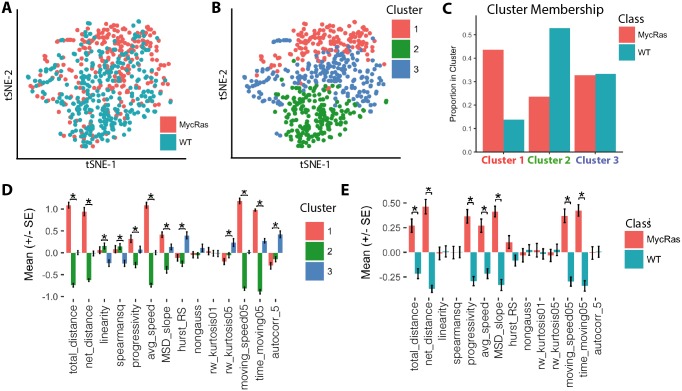
Wild-type and Myc/Ras transformed MEFs show differential occupancy within a shared motility state-space.(A) t-SNE visualization of wild-type (blue) and Myc/Ras transformed (red) MEFs in motility space (perplexity = 50). (B) Hierarchical clusters visualized with t-SNE (MANOVA, p < 0.001; Silhouette Si = 0.21). (C) Proportion of wild-type vs. transformed cells occupying each cluster. (D) Comparison of a subset of normalized feature values between clusters (*: Holm-Bonferroni corrected p < 0.01 by ANOVA) and (E) wild-type and transformed MEFs (*: Holm-Bonferroni corrected p < 0.01 by t-test). n > 250 cells per condition (pooled) from six independent experiments.